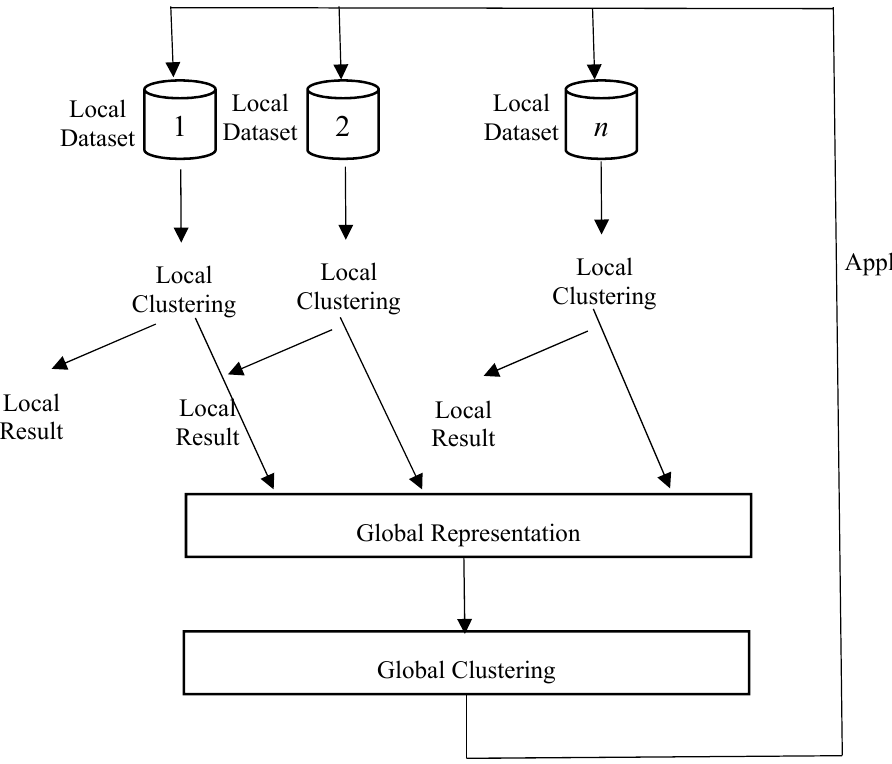
Figure 1. Distributed clustering in homogeneous databases.